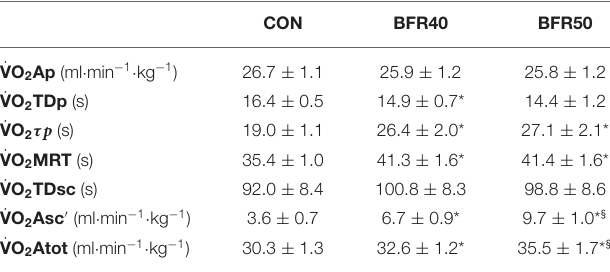
TABLE 1 | Oxygen uptake kinetics parameters for exercise without blood flow restriction (CON), with 40% (BFR40) or 50% (BFR50) occlusion. CON